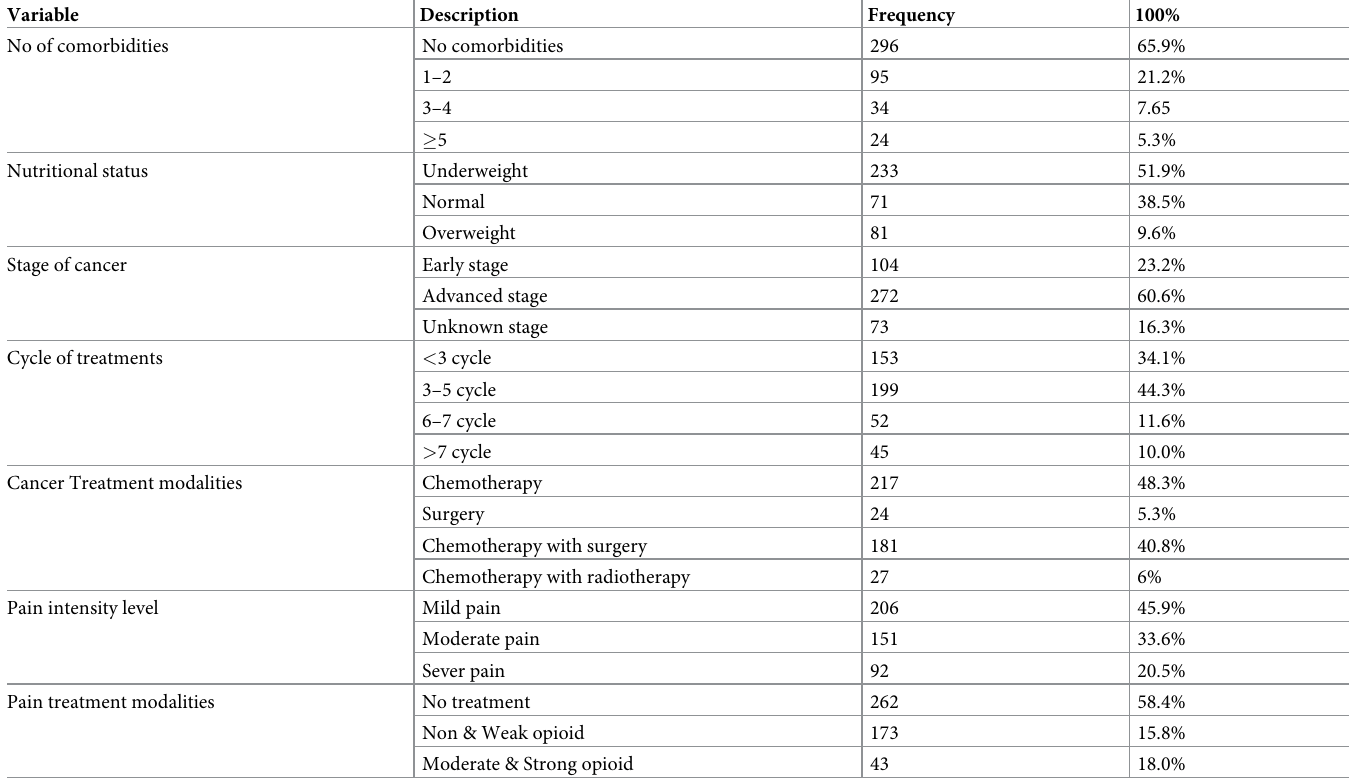
Table 5. Clinical characteristics of adult cancer patients receiving cancer treatment at oncology unit in Amhara region, Ethiopia, 2022 (N =